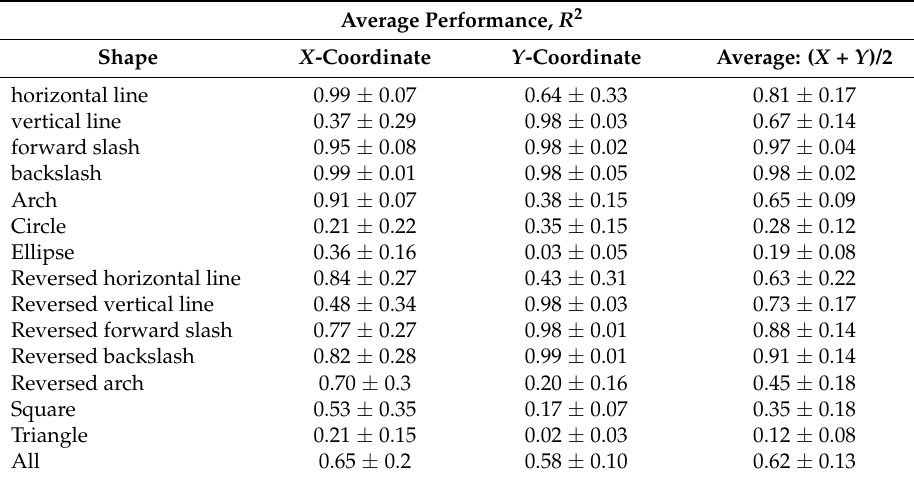
Table 6. Within-group reconstruction performance by the KF: the average accuracy of each shape across the five subjects.